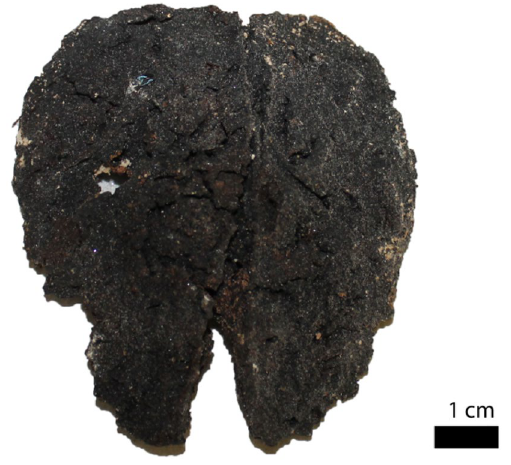
Figure 8. Preserved brain tissue referred to cranium MI CG 21 O-US4-155.